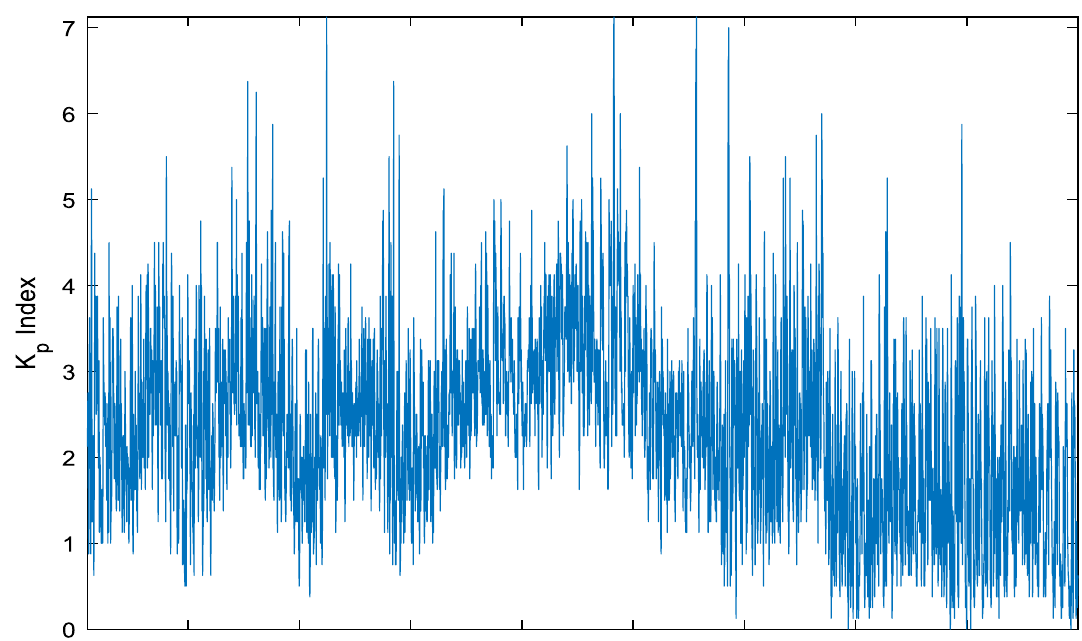
Fig. 1 Original K -index signal from the NOAA Space Weather Prediction p